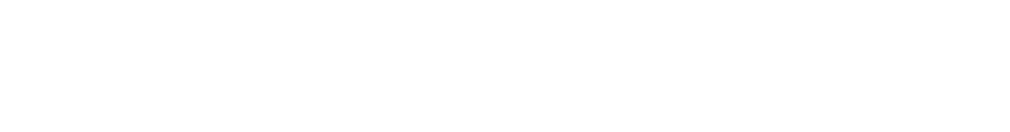
Logopediese Vereniging, Vol. 17, Nr. 1: Des.